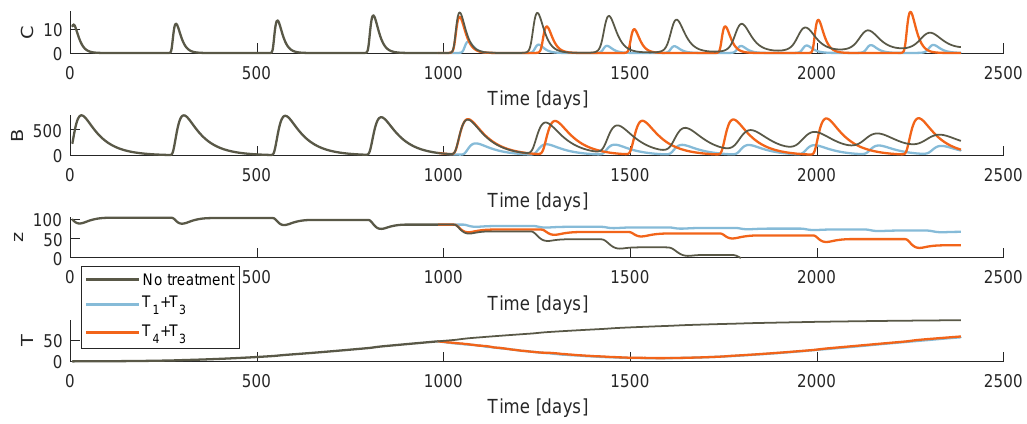
Figure 6. Model M DR 2 behaviour when the tumour arises at t = 0 and the treatment begins at t start = 980